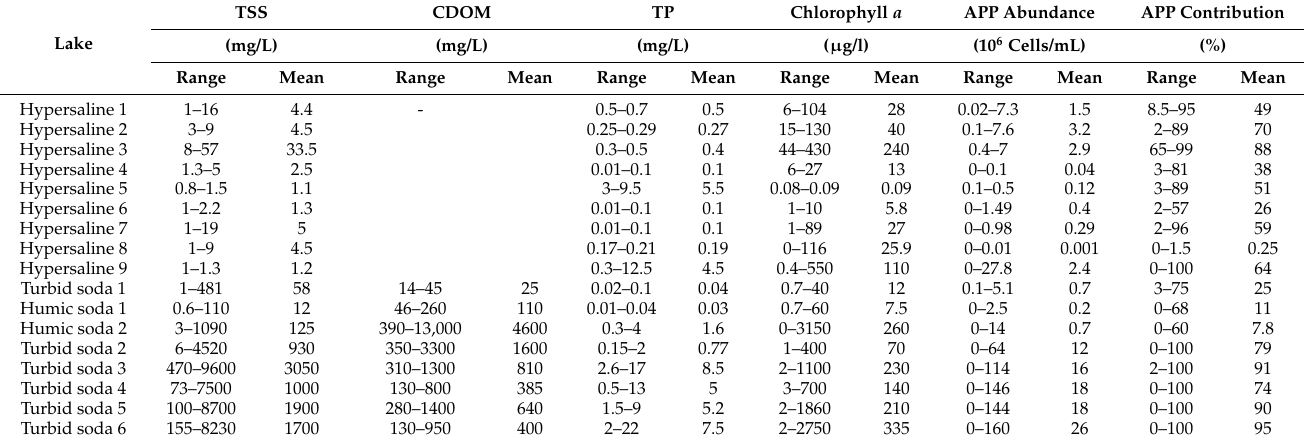
Table 1. Selected environmental variables of the studied lakes. Abbreviations: TSS—total suspended